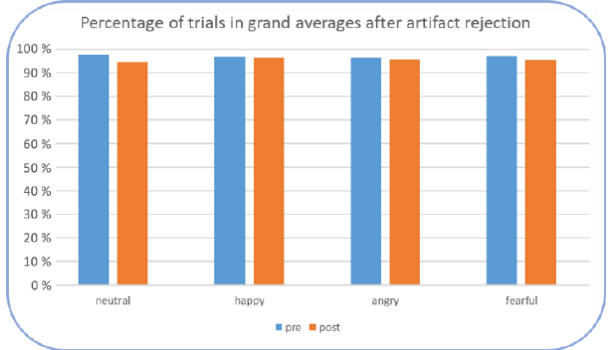
Figure 6. Mean percentage of included trials after artifact rejection in each emotional condition.